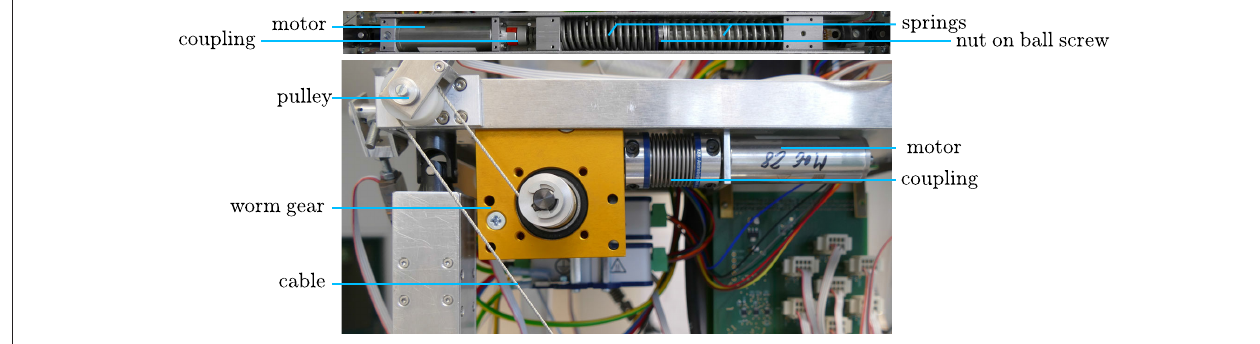
FIGURE 4 | Construction of parallel actuation in the columns ( Top , rotated by 90 ◦ ) and serial actuation for diagonal elements (Bottom) .